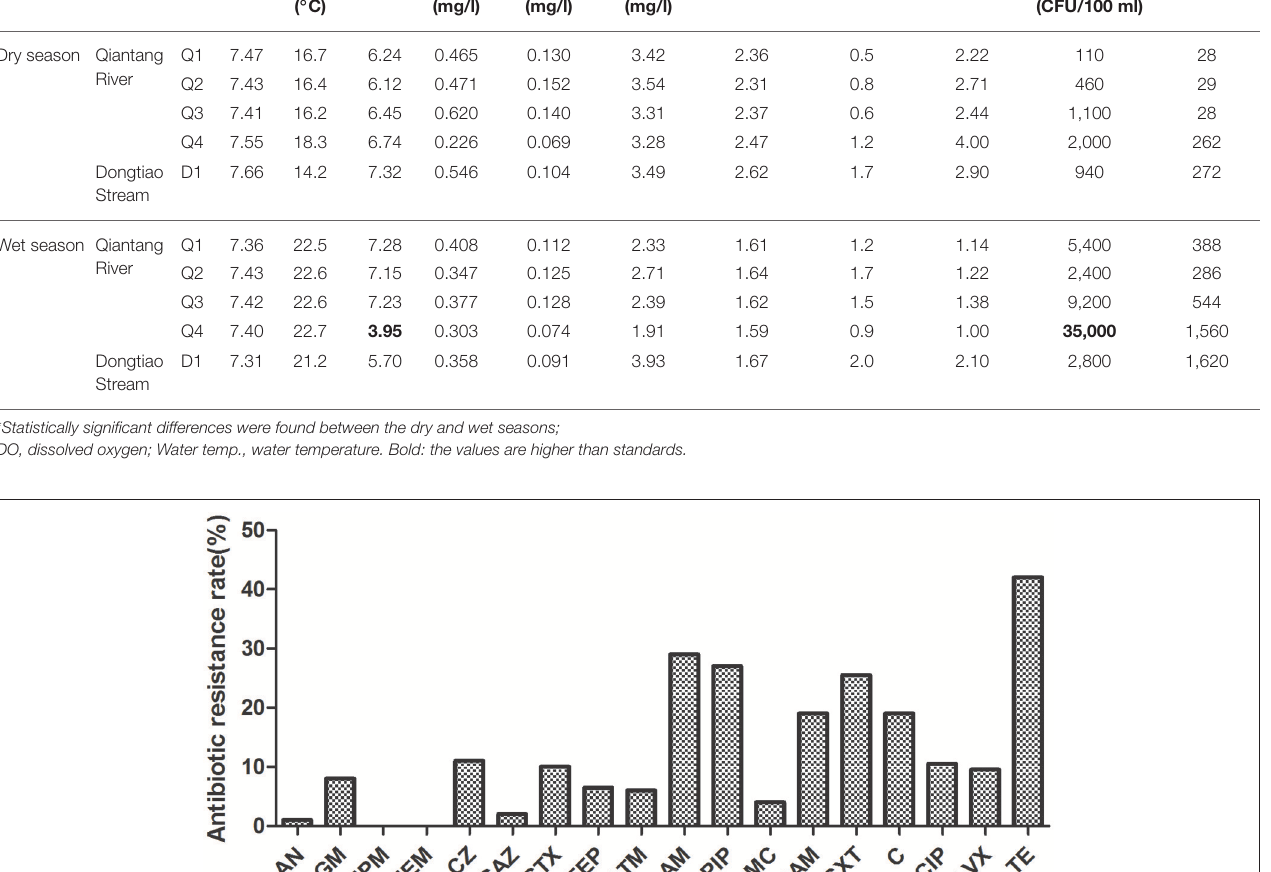
TABLE 2 | Water quality parameters of the Qiantang River and the Dongtiao Stream between the dry and wet seasons. Sampling Sources Sites PH periods